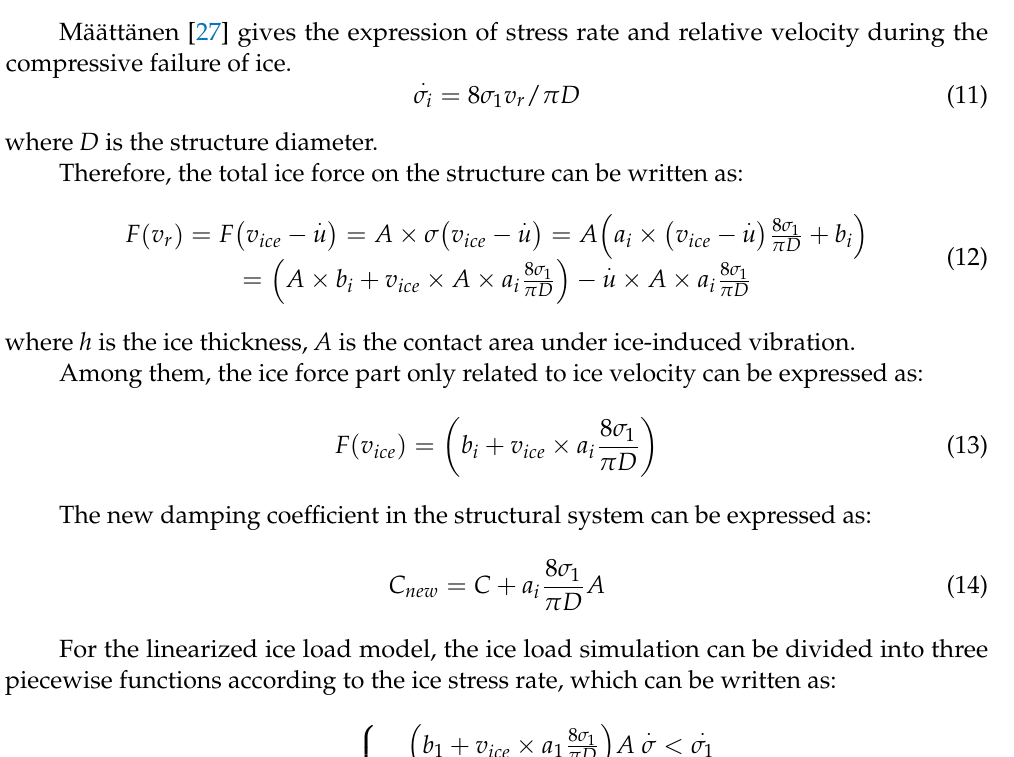
Figure 10. Linearized ice ‐ crushing strength versus stress rate.